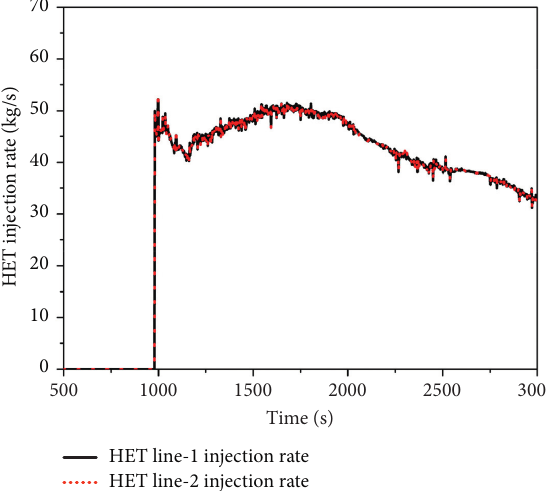
Figure 11: 10-inch CL break HET injection mass flow rate.